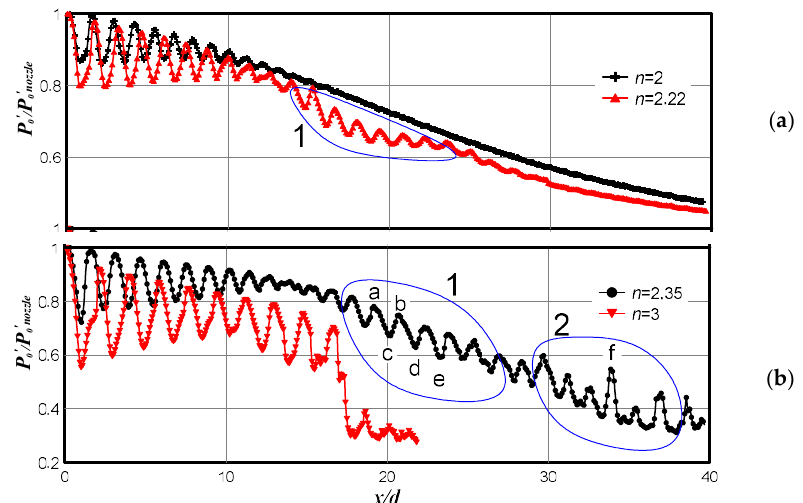
Figure 10. Pressure distribution in the model microjet escaping from the nozzle 1.06 mm in diameter (modeling exhaustion from the nozzle 16.1 µm in diameter). ( a ) n = 2 and 2.22, ( b ) n = 2.35 and 3.